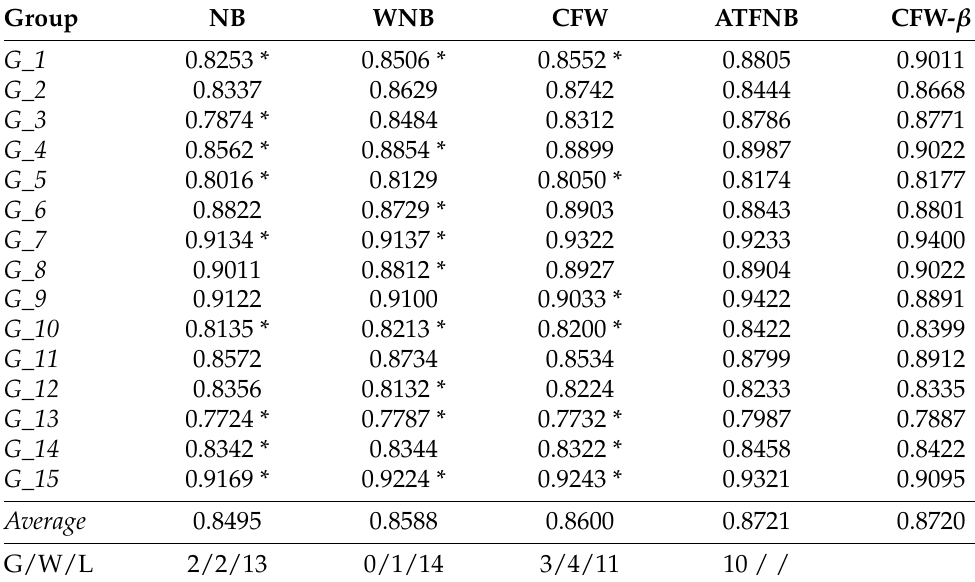
Table 9. Classification accuracy comparisons for ATFNB, NB, WNB, CFW, CFW- β on Flavia dataset. * indicates that ATFNB was significantly better than its competitors (NB, WNB, CFW) through a two-tailed t -test at the p = 0.05 significance